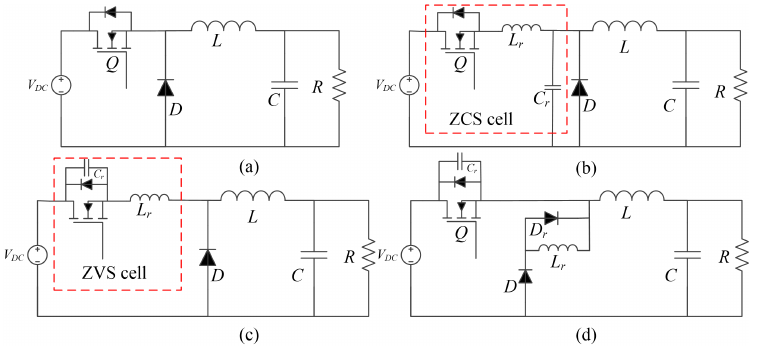
Figure 2. Buck converter and quasi-resonant buck converters; ( a ) buck, ( b ) ZCS quasi-resonant, ( c ) ZVS quasi-resonant and ( d ) modified converters.